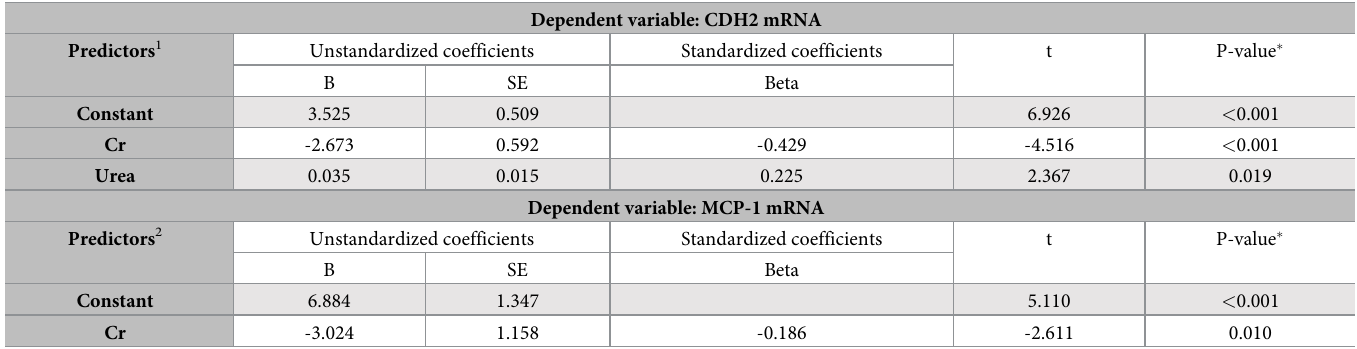
Table 6. Multivariable linear regression analysis on the parameters affecting CDH2 and MCP-1 mRNAs